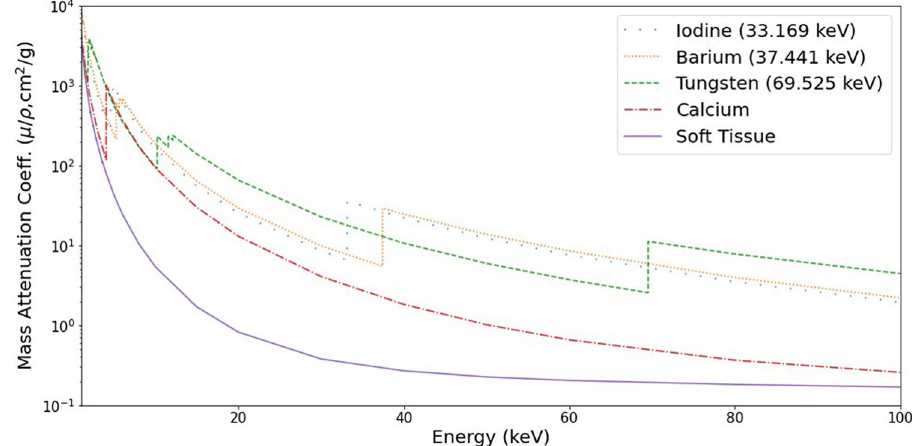
Figure 1. Attenuation variation as a function of energy. Known values of the mass attenuation coefficient shown for a number of materials. Across the hard X-ray energy range, many elements exhibit sharp rises in attenuation at their absorption edge positions (K-edge energies given in legend), providing strong contrast relative to soft tissue or bone (calcium) structures. Values extracted from the NIST online database 2